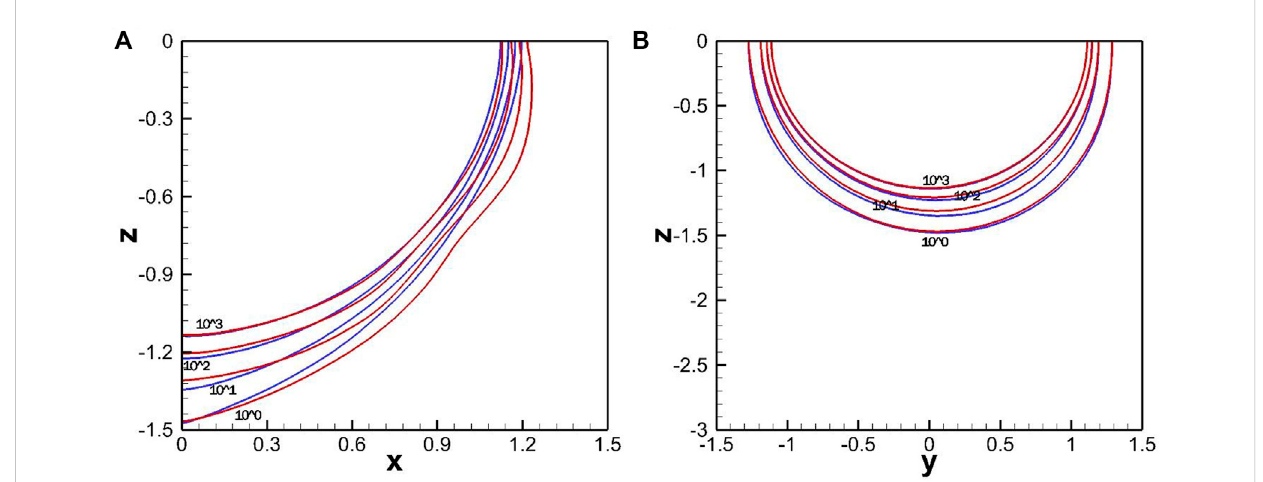
FIGURE 6 Theisocontoursofthelogarithmicplanetaryionnumberdensityonthesouthernx-zplane (A) andsouthernterminator (B) .Red/bluelinerepresents the case with/without crustal fi elds.